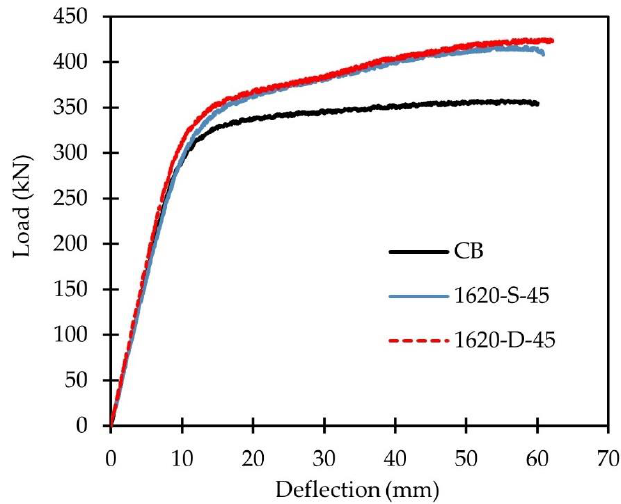
Figure 15. Load – deflection curves of 1620-S-45, 1620-D-45 and CB.